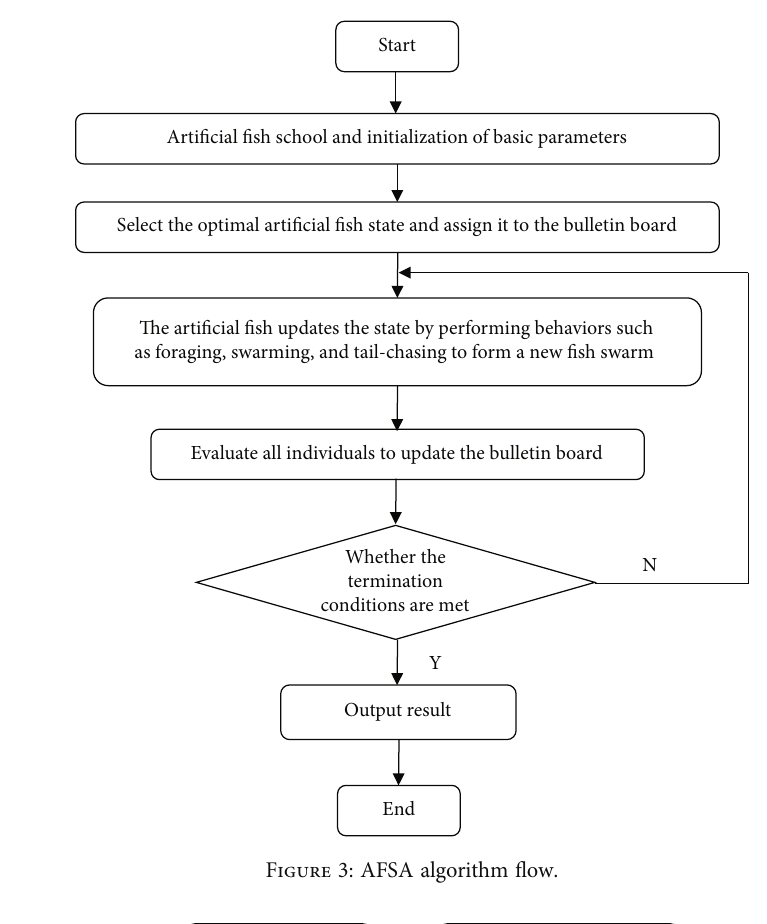
Figure 3: AFSA algorithm fl ow.